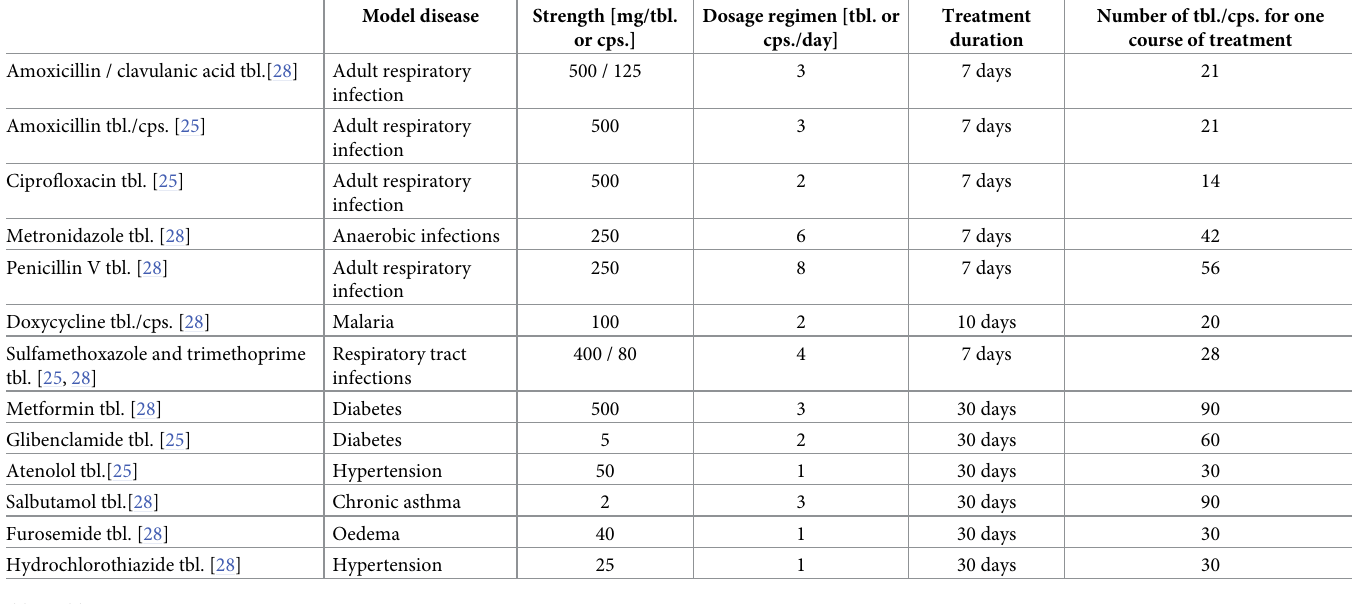
Table 1. Medicines included into this study and calculation of medicine amount of the preferred strength used for one course of treatment. Model disease Strength [mg/tbl. or